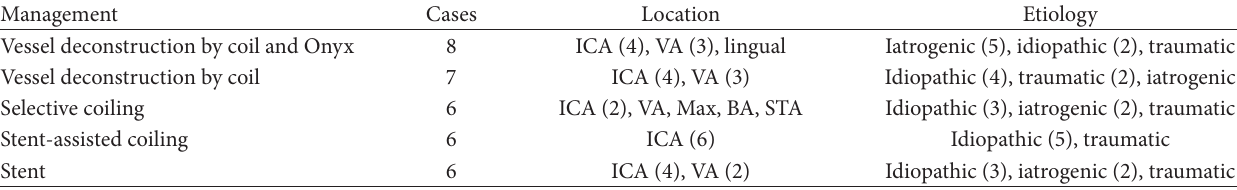
Table 1: Pseudoaneurysm intervention: breakdown of location and etiology.